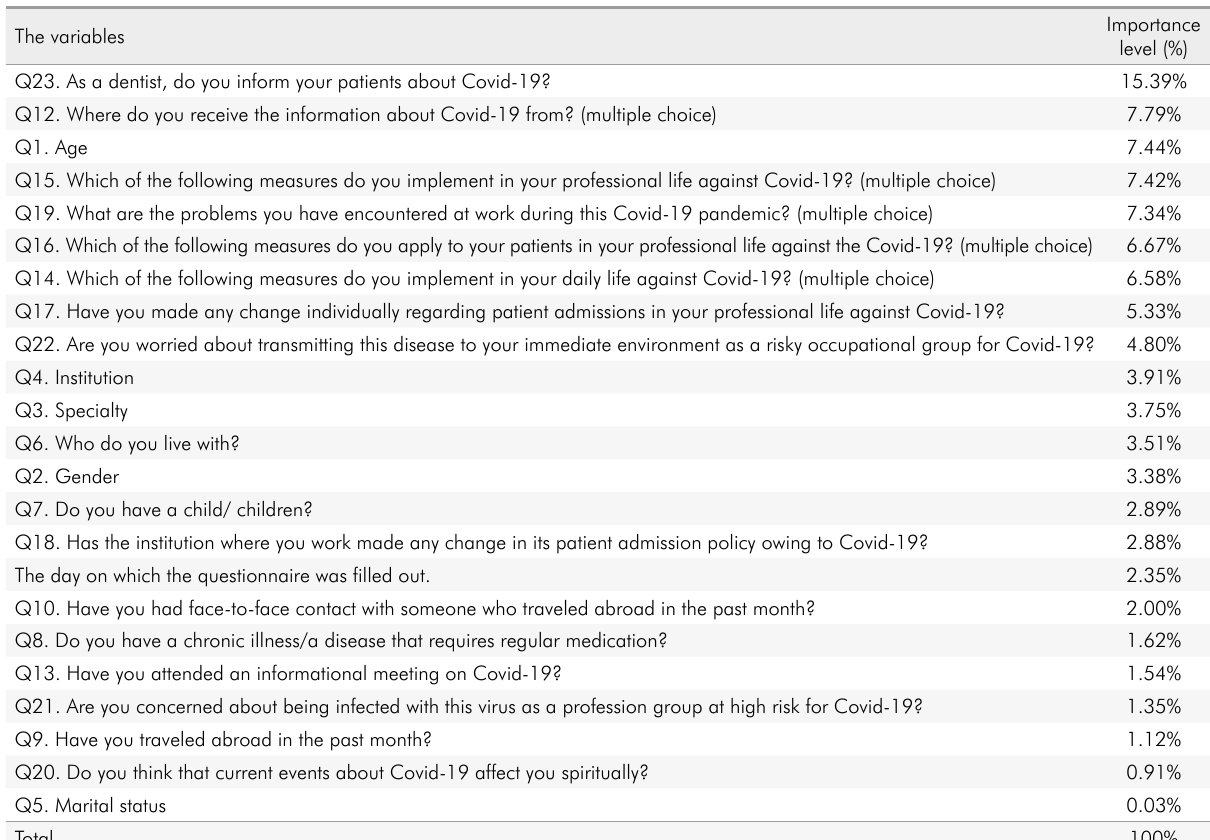
Table 4. The importance levels of the related variables for the dentists’ self-assessed COVID-19 knowledge score according to the MLP ANN model.